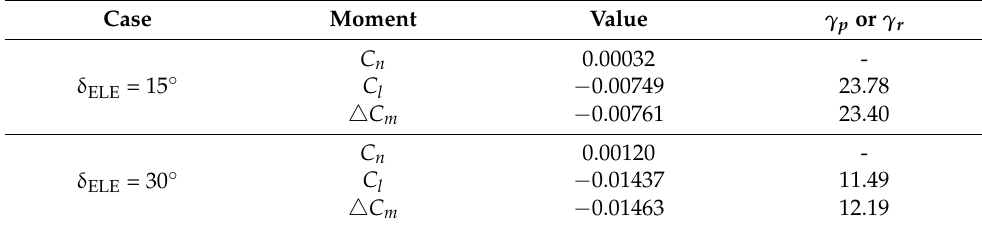
Table 2. Aerodynamic moments characteristics of the elevon at α = 6°.